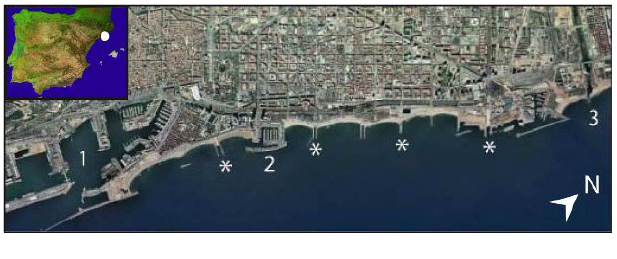
Fig. 1 . Coastline of Barcelona, indicating beaches, industrial harbors (1), recreational harbors (2), combined sewer overflow outlets (*), and the mouth of the River Besòs (3). (Data source: Cartographic Institute of